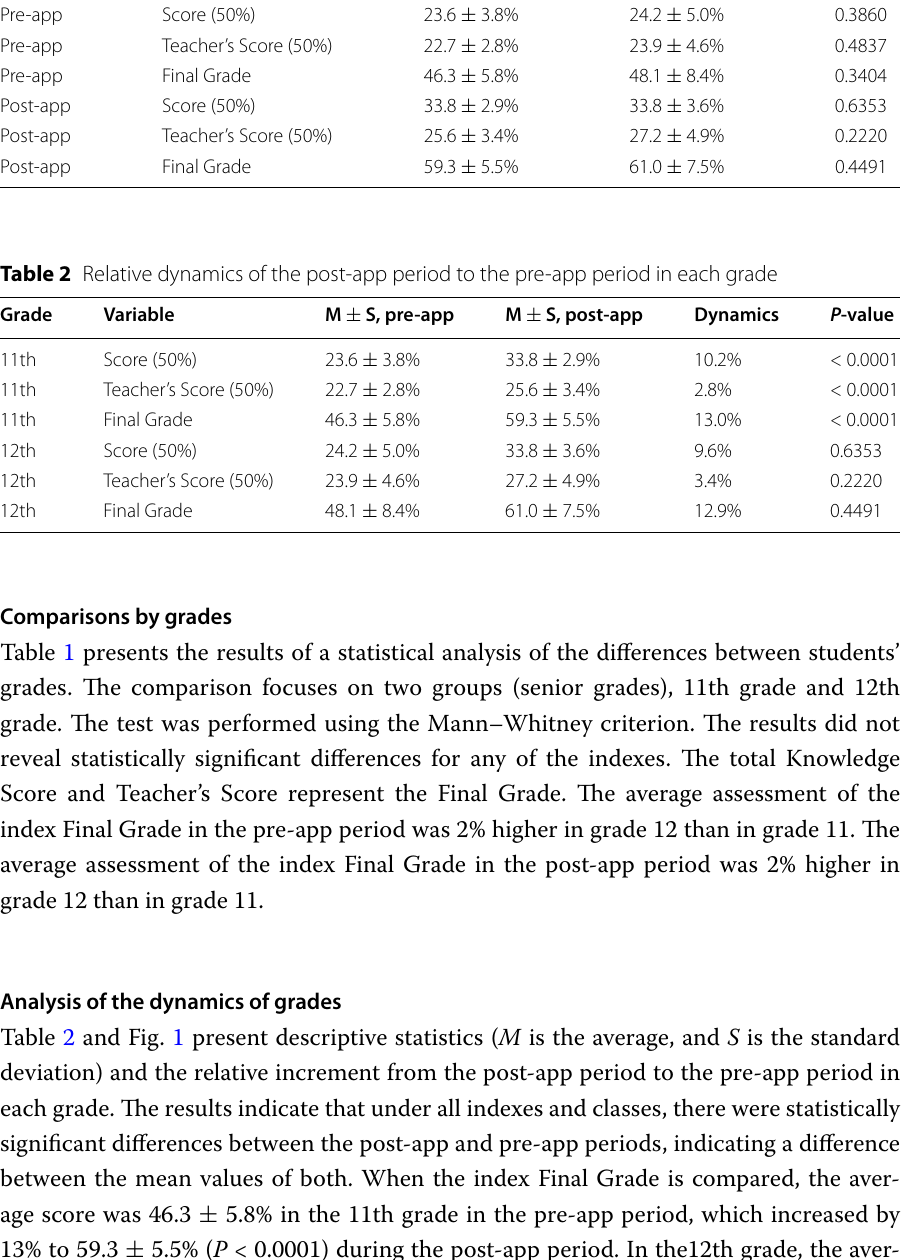
Table 1 Comparison of scores between grades Grades Period